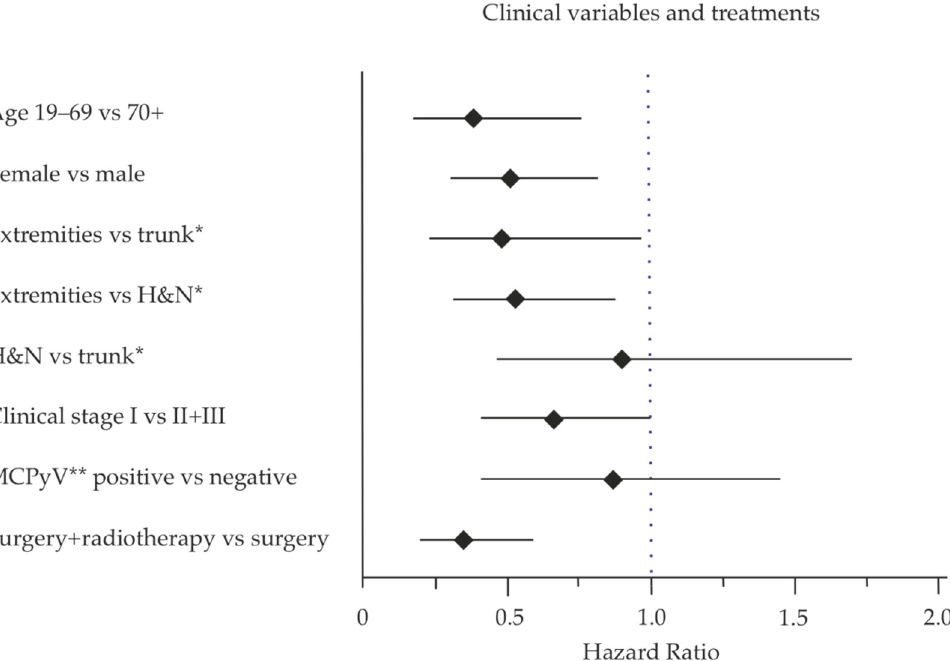
Figure 4. Forest plot for the hazard ratio of the clinical variables and MCPyV-status. * For both sexes, differences are shown in Table 2. ** For both sexes, differences are shown in Table